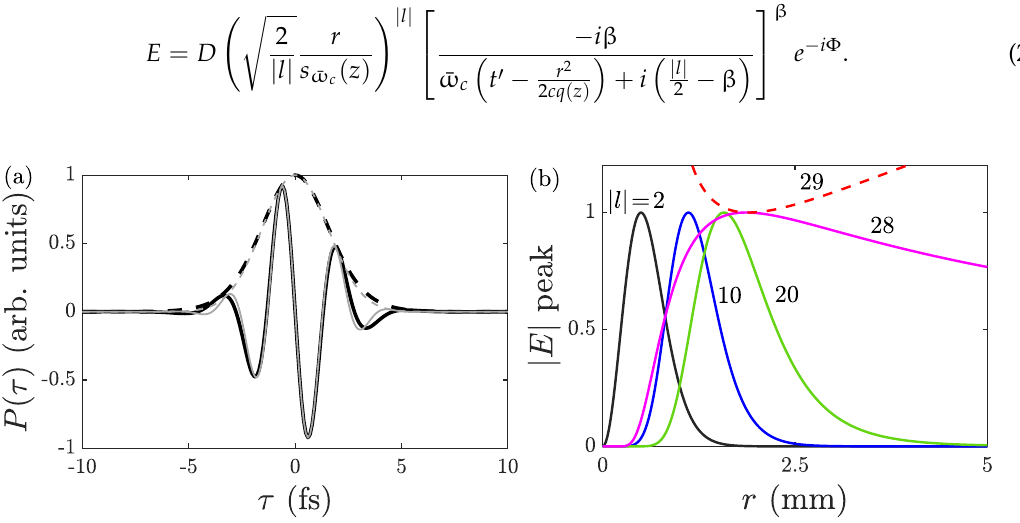
Figure 3. ( a ) The real part (black solid) and amplitude (black dashed) of the pulse P in Equation (28) with ¯ ω c = 2.417 rad/fs (780 nm wave length), β = 14.24, and Φ = π /2, containing a single oscillation within its full width at half maximum in intensity, and its approximation P c = e − τ 2 / ∆ t 2 c e − i ( ¯ ω c τ + Φ ) , with ∆ t c = 2.208 fs (gray curves). ( b ) Peak amplitudes of the ultrafast vortices of Rayleigh distance (cid:112) | ( z ) as functions of radius as given by z R = 1 m with the pulse shape P ( τ ) at r E ( z ) = l | /2 s ¯ ω c (cid:112) | ( 0 ) l | /2 s ¯ ω Equation (30) at z = 0 and for increasing values of l , featuring maxima at r E ( 0 ) = c (cid:112) | ( 0 ) for | l | > 2 β , with a singularity at a smaller radius, l | /2 s ¯ ω for | l | < 2 β and minima at r E ( 0 ) = c and thus lacking physical